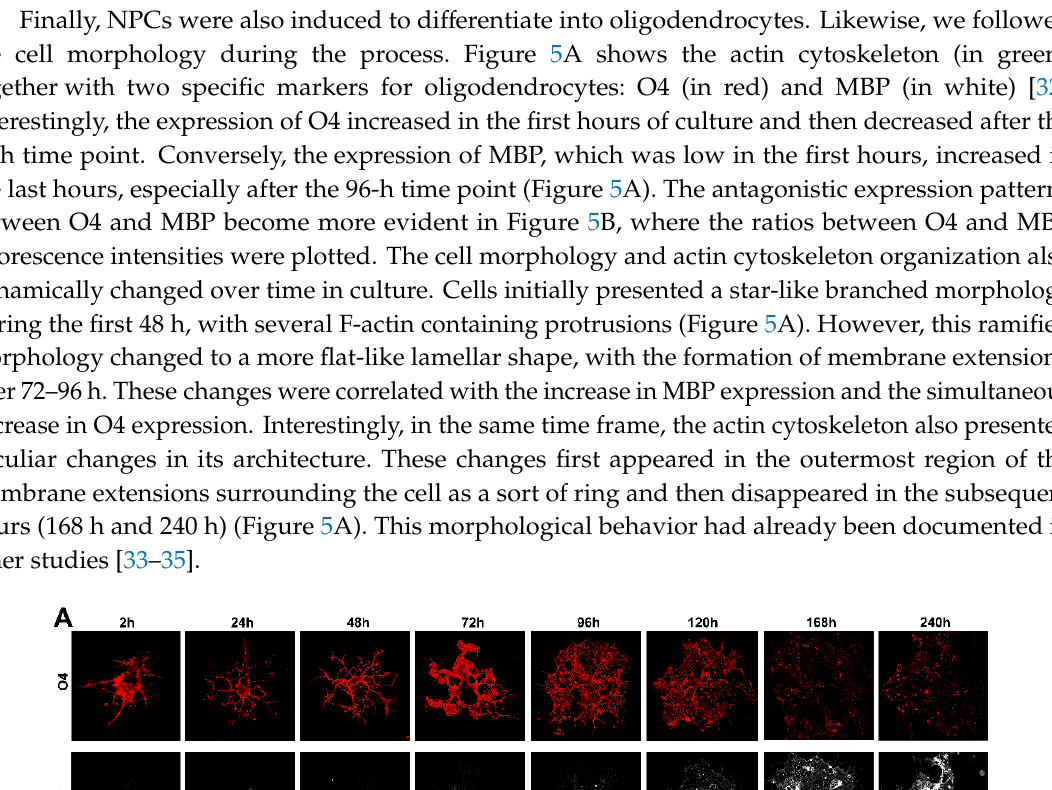
240 h. Scale bars are all 10 µ m. ( B ) Plot of the mean CTCF values for GFAP within 2 h to 240 h of culture. ( C , D ) Plot of the mean anisotropy values of F-actin staining ( C ) and GFAP staining ( D ) after FibrilTool analysis. At least 10 di ff erent cells for each experimental condition were analyzed. Standard errors were used as error bars in B, C and D. They all show similar behaviors as the ones represented in A. ( E , F ) Plots of tether force (at least 16 di ff erent cells) ( E ) and tether radius values (at least 10 di ff erent cells) ( F ) for each time point. The colored boxes extend from 25th to 75th percentiles, with a black horizontal line at the median and a black cross at the mean; black whiskers extend from 5th to 95th percentiles; values outside these ranges are plotted as individual points. * means p < 0.05, ** means p < 0.01, *** means p < 0.001, **** means p < 0.0001 in Mann-Whitney U -test statistics when comparing each time point with the 2 h condition.